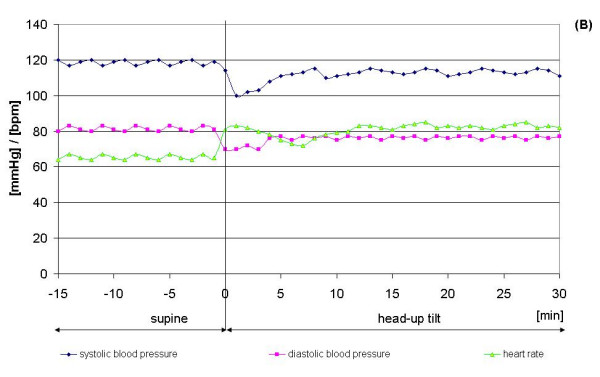
Typical recordings illustrating a subject without syncope. RF = M. rectus femoris, BF = M. biceps femoris, TA = M. tibialis anterior, GM = M. gastrocnemius